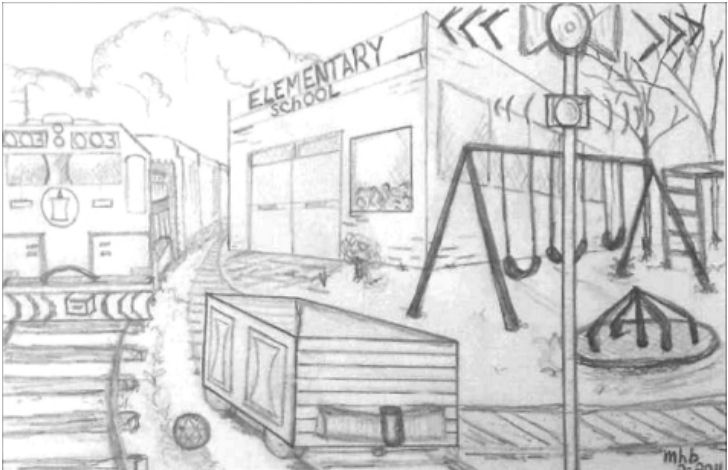
Figure 11. Sketch by Marihelen Ballard, Strawberry Plains, Tennessee, of a school in close proximity to a freight train traveling to a rail yard; reprinted with permission of the Jefferson County Post in New Market TN.